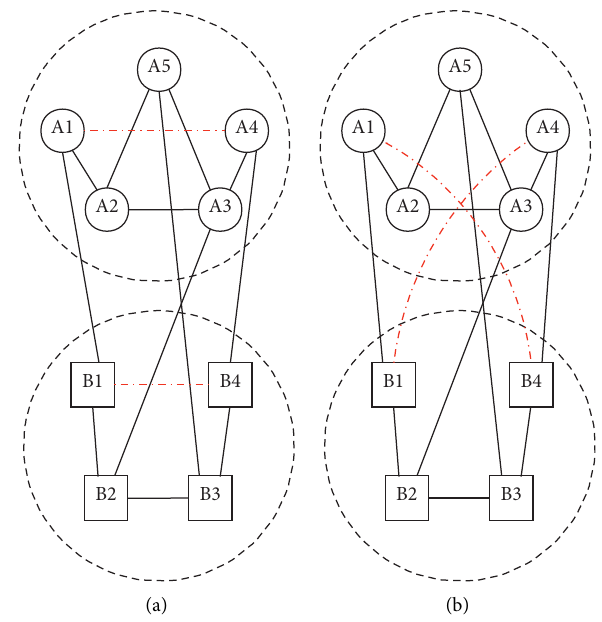
Figure 3: The operation of edges rewiring for weakening community